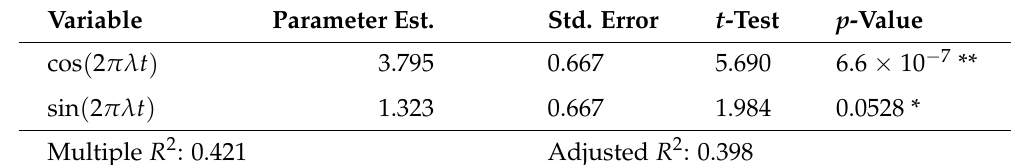
Table A1. Regression output for model